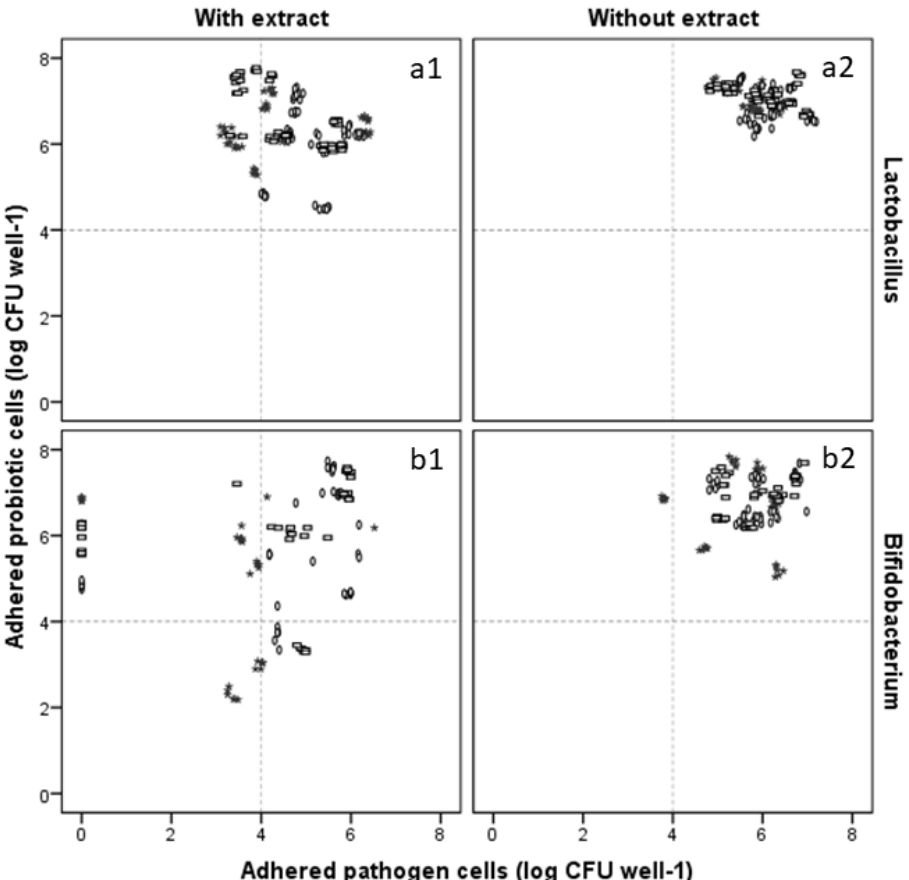
Figure 8. Effect of blueberry extract (presence (1) and absence (2)) upon the adhered probiotic and pathogen viable cells when considering Lactobacillus ’ ( a ) and Bifidobacterium ’s ( b ) adhesion in the presence of E. coli ( 0 ), S. enteritidis ( ), and L. monocytogenes ( □ ).